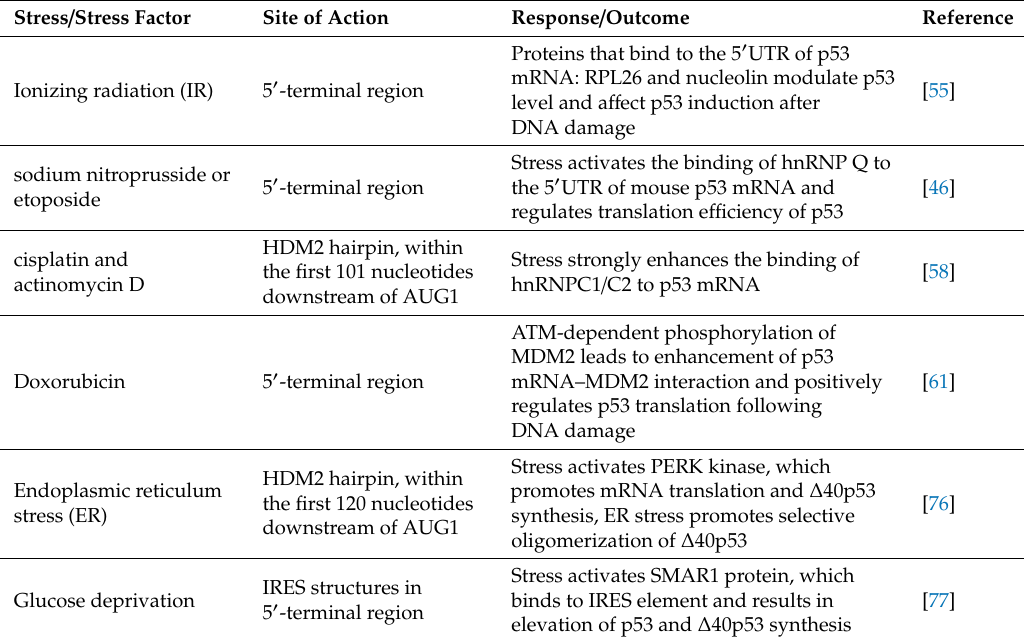
Table 1. The influence of cellular stress on p53 and ∆ 40p53 proteins